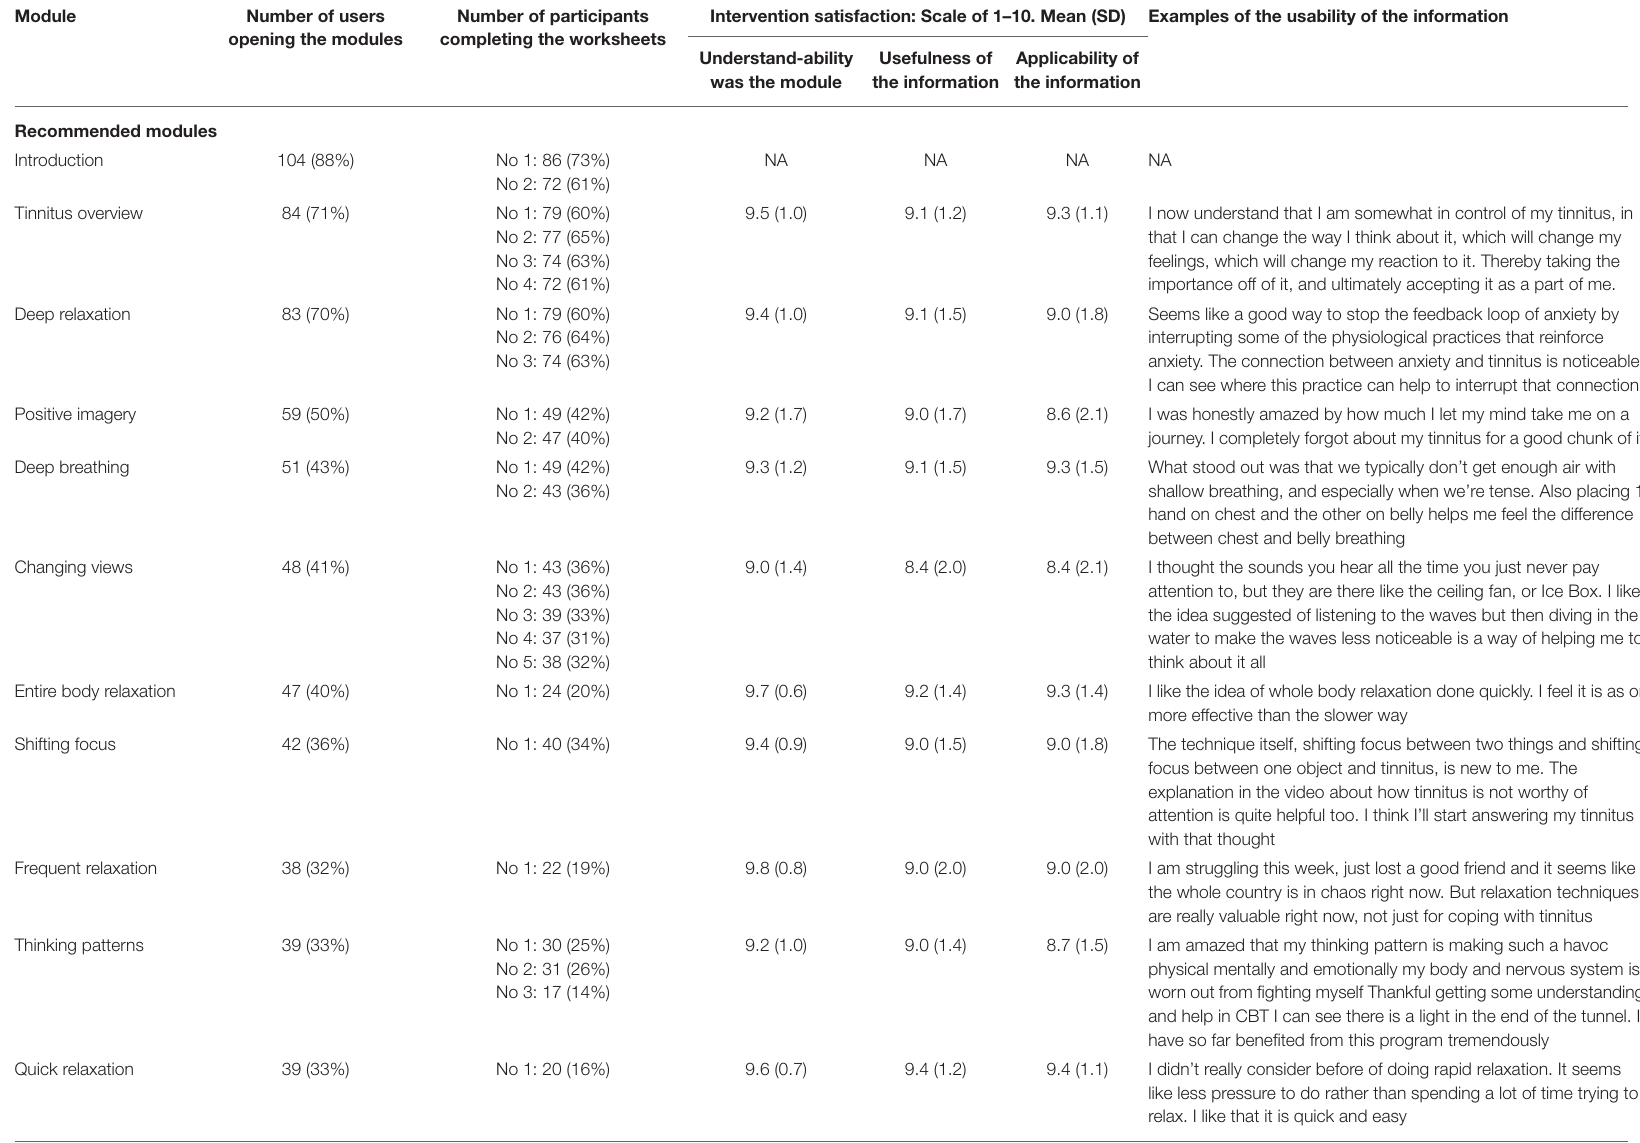
TABLE 5 | The engagement and satisfaction with the intervention. Module Number of users Number of participants Intervention satisfaction: Scale of 1–10. Mean (SD) Examples of the usability of the information opening the modules completing the worksheets Understand-ability was the